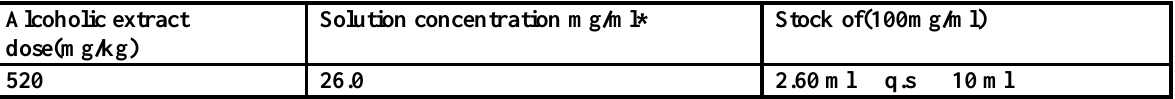
Table (1): Standard dose and dilution of N.oleander alcoholic extract.*0.2 ml/10 gram of mouse. Alcoholic extract dose(mg/kg)